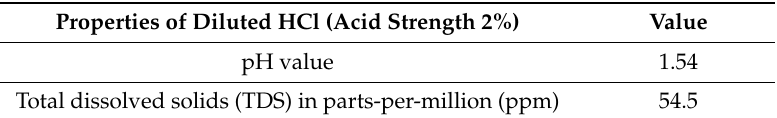
Table 6. Properties of the diluted acid solution.